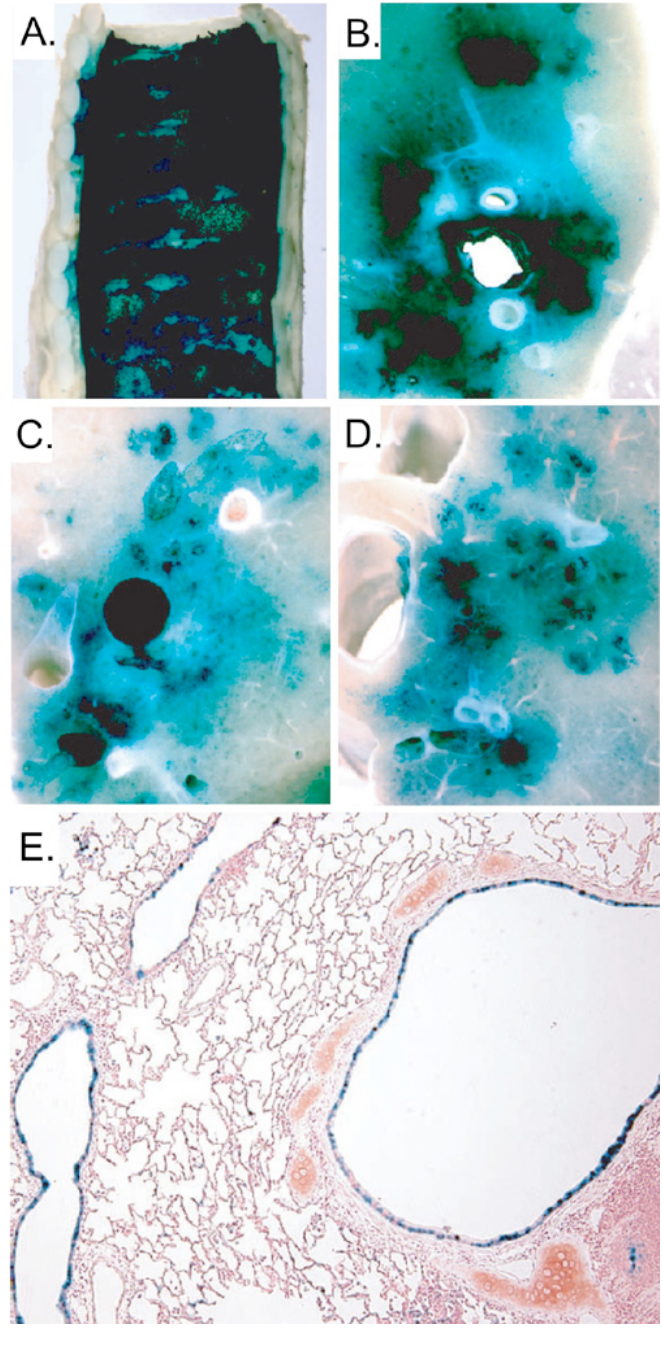
Figure 4. Pulmonary transduction in rabbits following intratracheal aerosolization of L-a lysophosphatidylcholine and HDAd expressing LacZ under the control of the K18 promoter. X-gal stained (A) trachea, (B) right upper lobe, (C) left lower lobe, (D) right lower lobe and (E) bronchus and